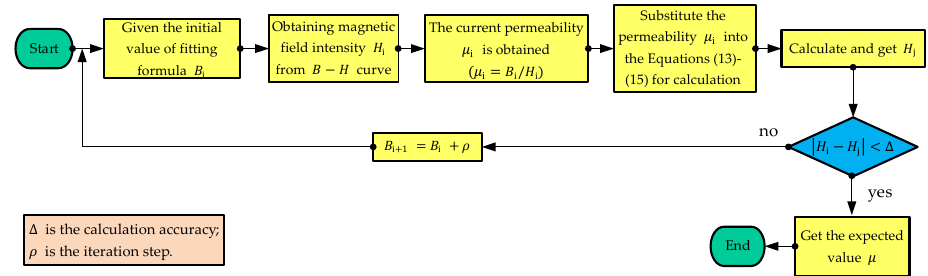
Figure 11. The iterative steps for solving nonlinear magnetic circuit